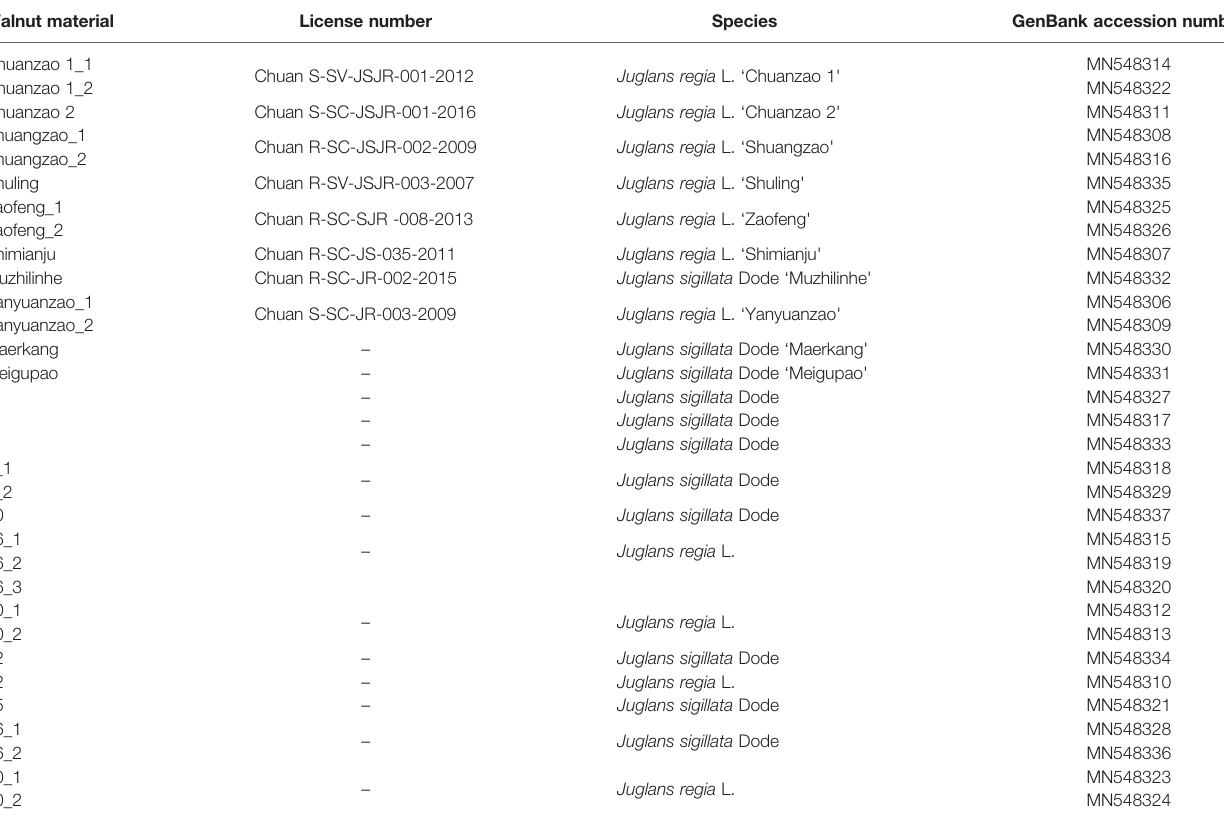
TABLE 1 | The 22 materials used in this study, including 10 cultivars and 12